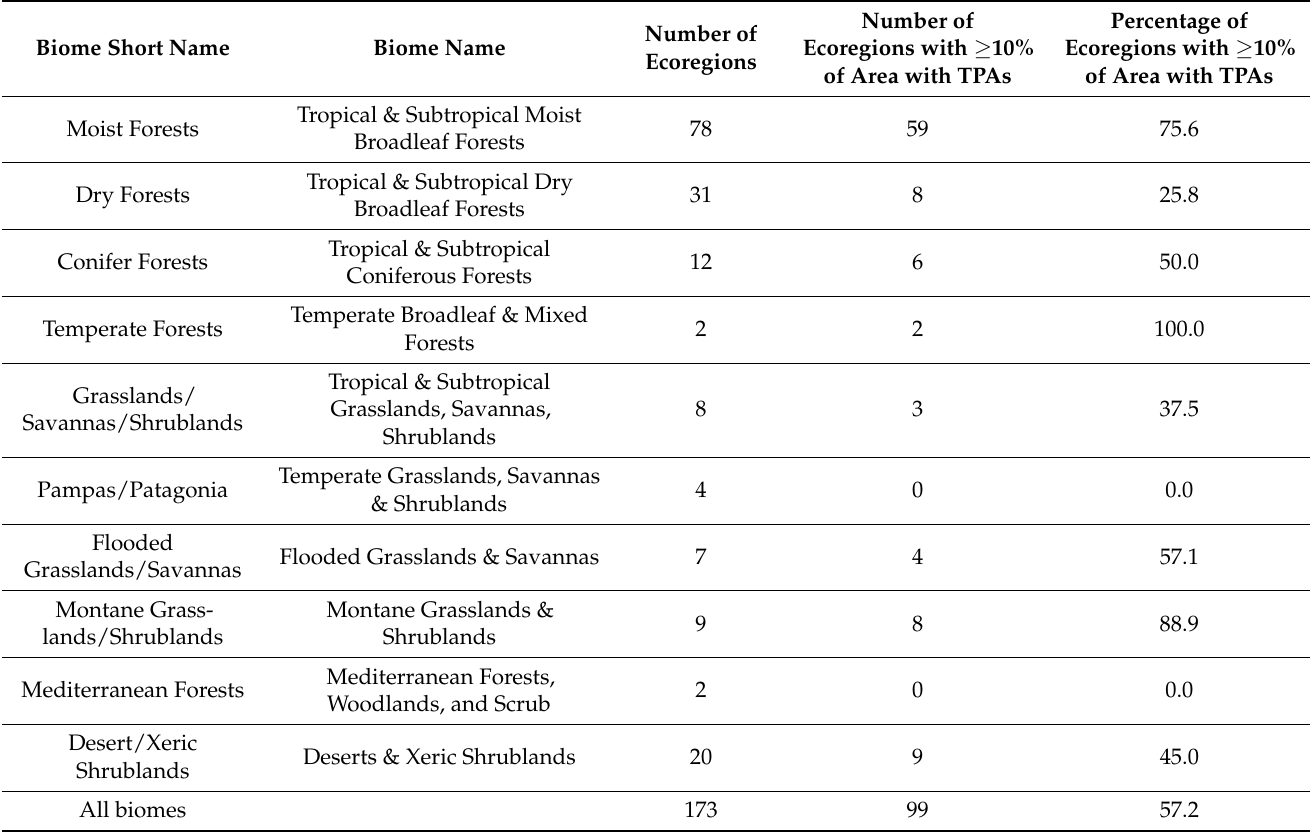
Table 3. Biome abbreviated name, biome name, number of ecoregions, and number of ecoregions with 10 or more percent of the area with TPAs and its corresponding percentage